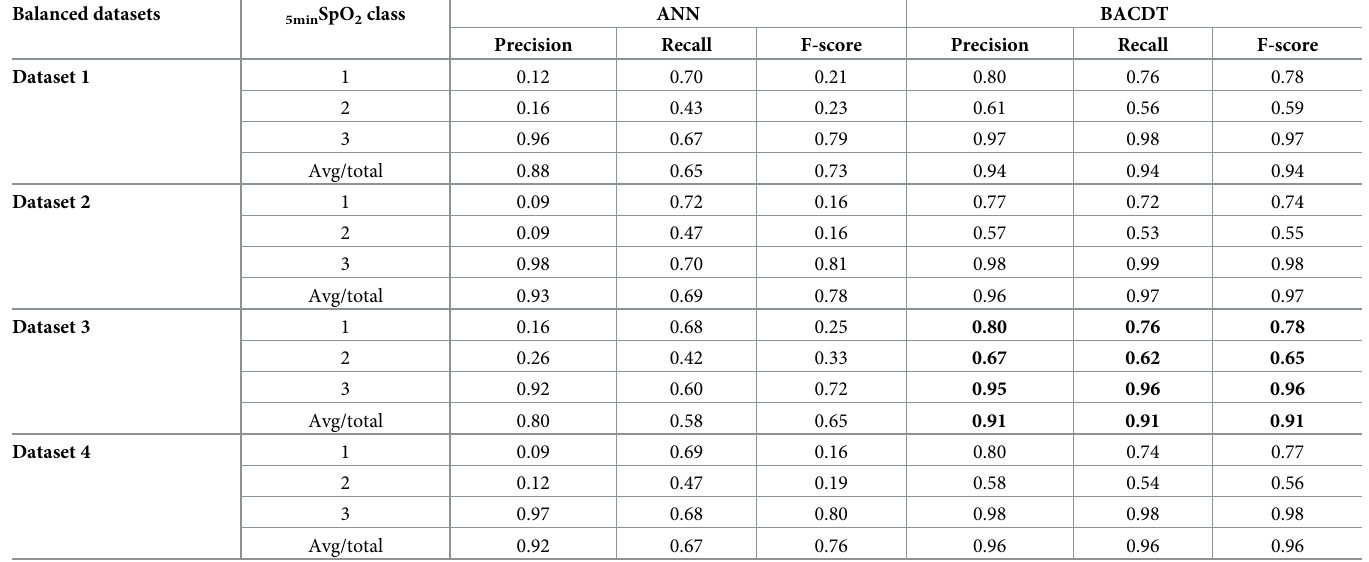
Table 3. Performance of artificial neural networks (ANN) and bootstrap aggregation of complex decision trees (BACDT) classifiers for SpO 2 prediction at 5 min following a ventilator setting change, on test datasets (see Table 2). Avg/total: average accuracy of total classification values. In italics is the performance of the best pre- dictive model obtained among the eight tested.